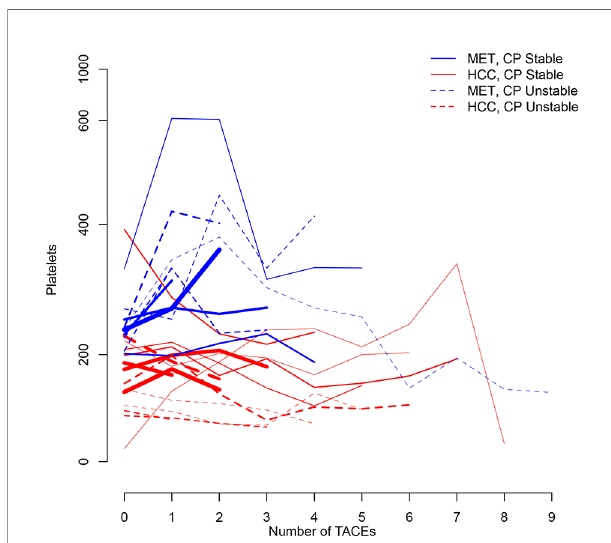
FIGURE 1 | Trajectory plot illustrating longitudinal changes over time in platelet count according to the number of TACEs and strati fi ed by Child-Pugh (CP) stability (line = stable, dotted line = unstable) and metastatic (MET)/HCC groups. Line thickness is proportional to patient number (the thicker the line the more patients).